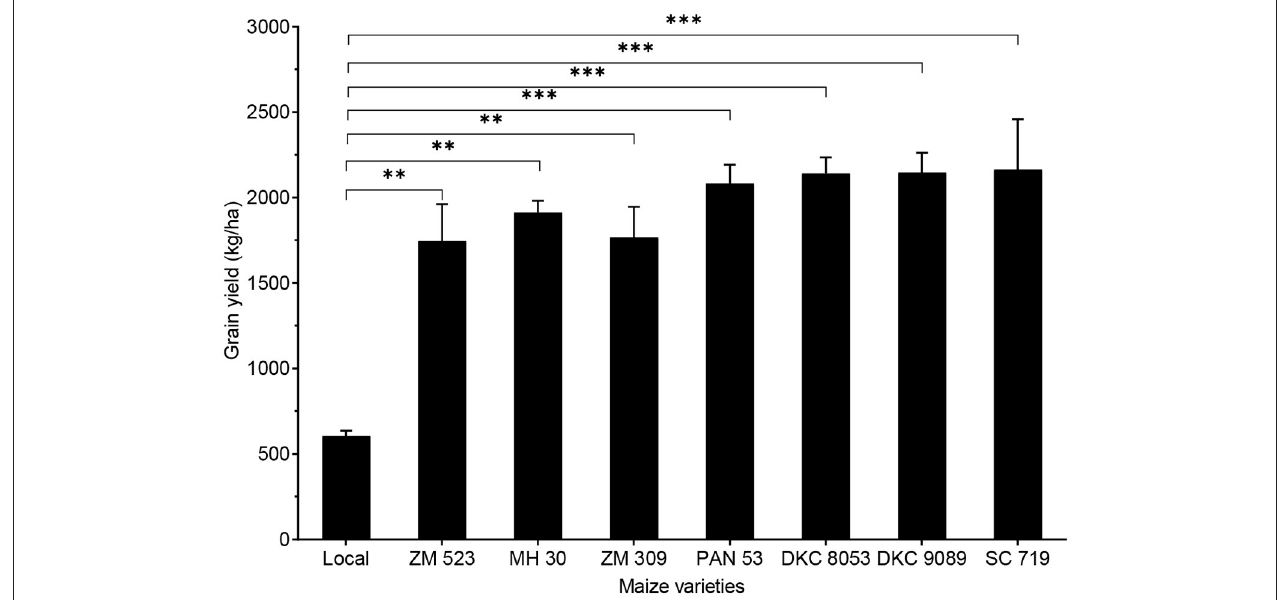
FIGURE 1 | Grain yield of eight maize varieties grown in Malawi. Error bars represent standard error of mean (SEM). ** and *** mean significant at 0.01 and 0.001, respectively, Tukey’s honest significant difference (HSD)